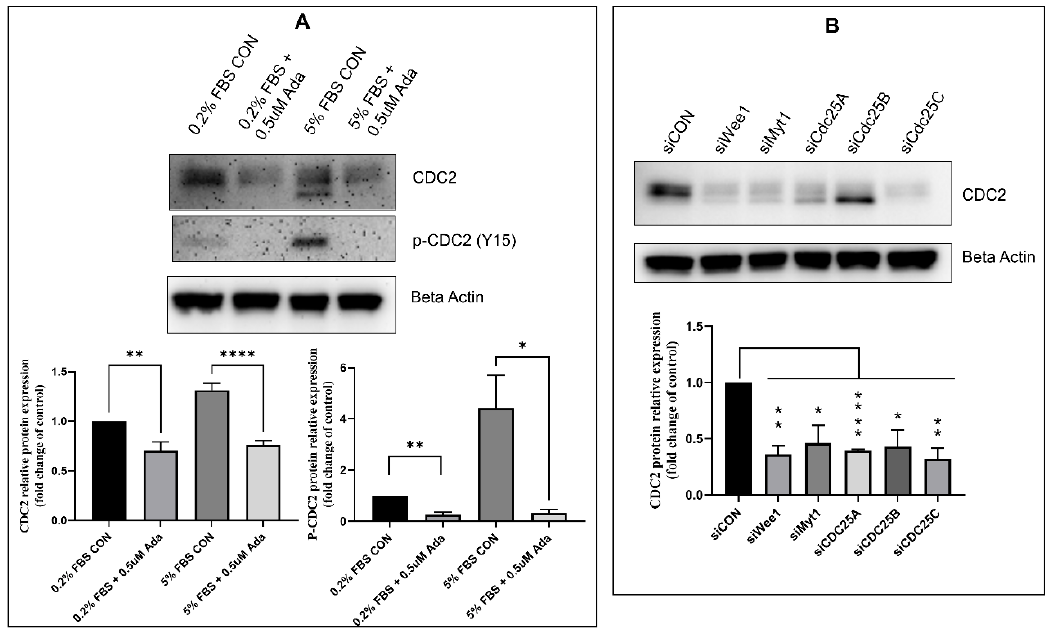
Figure 5. Effect of Wee1 inhibition on CDC2 expression in PAH HPASMC. ( A ) Western blot showing the effect of adavosertib (Ada) on the expression of total and p-Tyr15 CDC2 in PAH HPASMC. T-test performed on CON vs. Ada for each pair. ( B ) Western blot showing the effect Wee1, Myt1, CDC25A, CDC25B, CDC25C, or scramble siRNA (siCON) knockdown on the expression of CDC2 in PAH HPASMC. T-test performed on siCON vs. each siRNA. Images are representative of at least triplicate experiments. Bar graphs indicate group means for these experiments and the error bars represent the standard deviation. *- p < 0.05, **- p < 0.01 and ****- p < 0.0001.